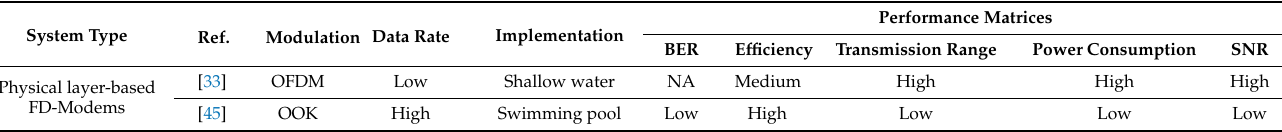
Table 2. Comparison of various full-duplex underwater acoustic